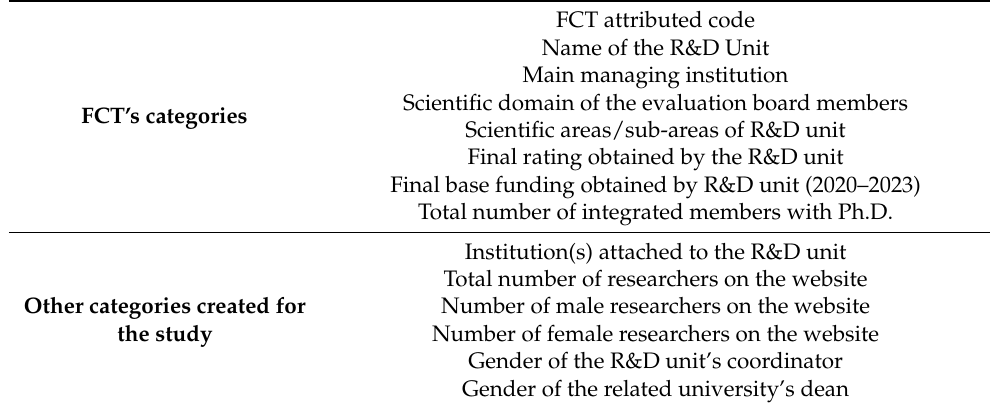
Table 2. Categories in the data analysis.